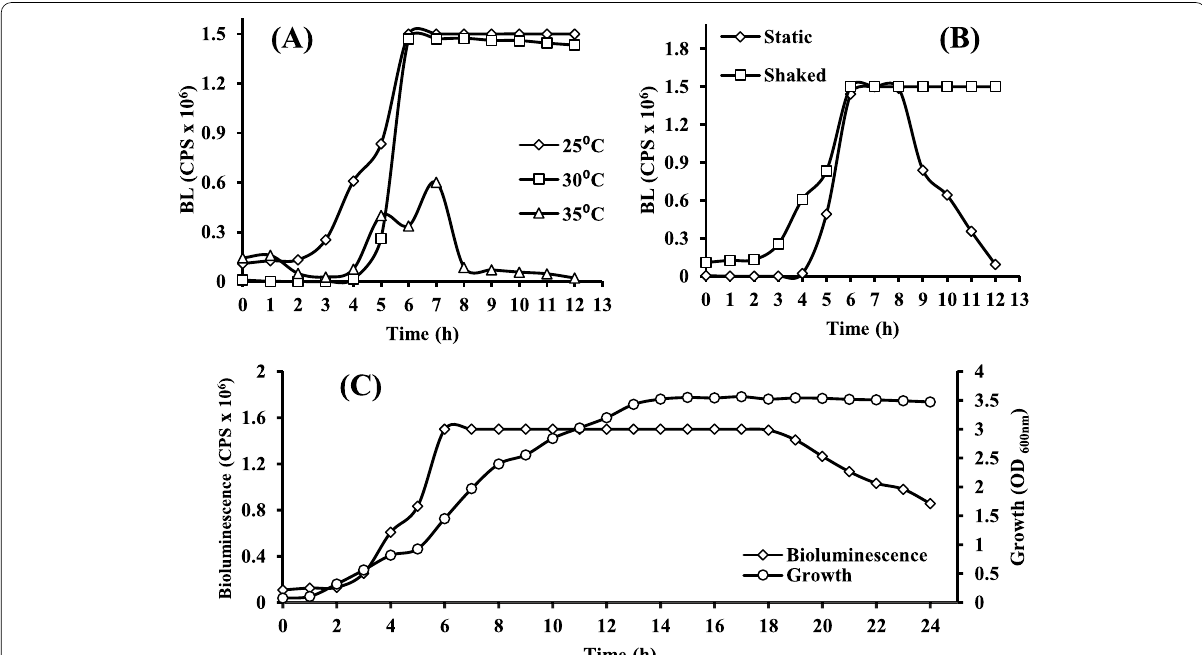
Fig. 3 Bioluminescence of V ibrio sp. 6HFE grown on LA broth at different temperatures ( A ), under shaked and static conditions ( B ), and correlation between bioluminescence of V ibrio sp. 6HFE and its growth ( C